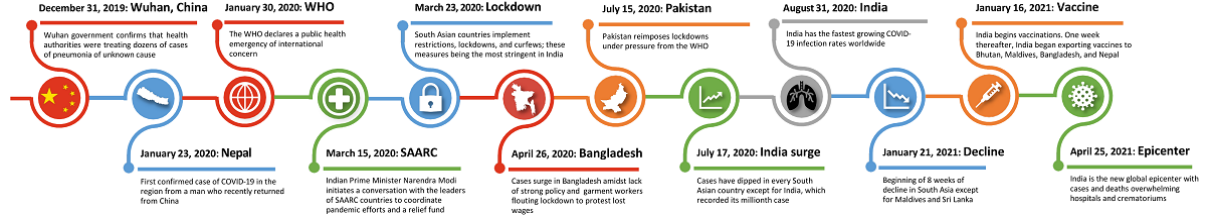
Figure 1. Timeline of COVID-19 events in South Asia. SAARC: South Asian Association for Regional Cooperation, WHO: World Health